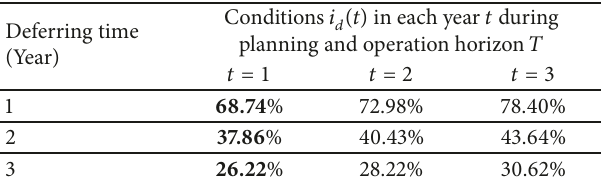
Table 10: Conditions for deferring this railway project in Scenario